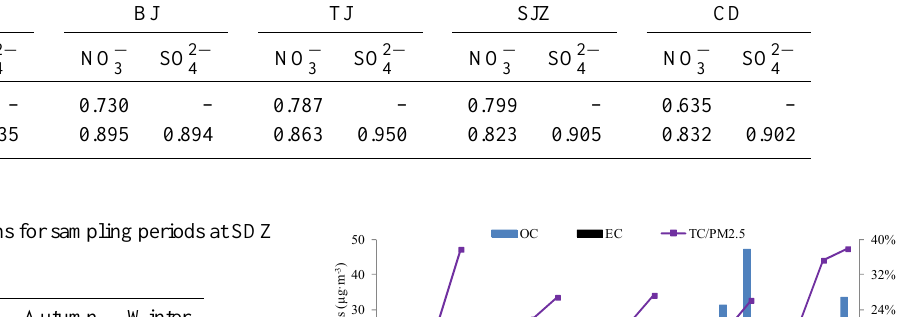
Table 4. Correlation coefficients among NH +